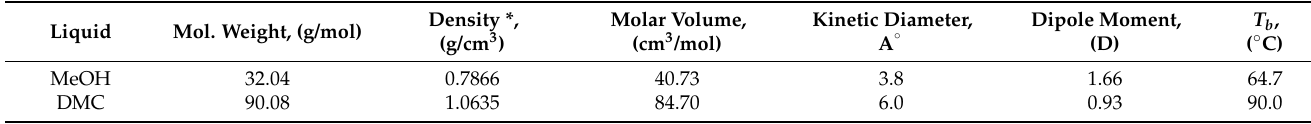
Table 3. Physical properties of liquids under the study.